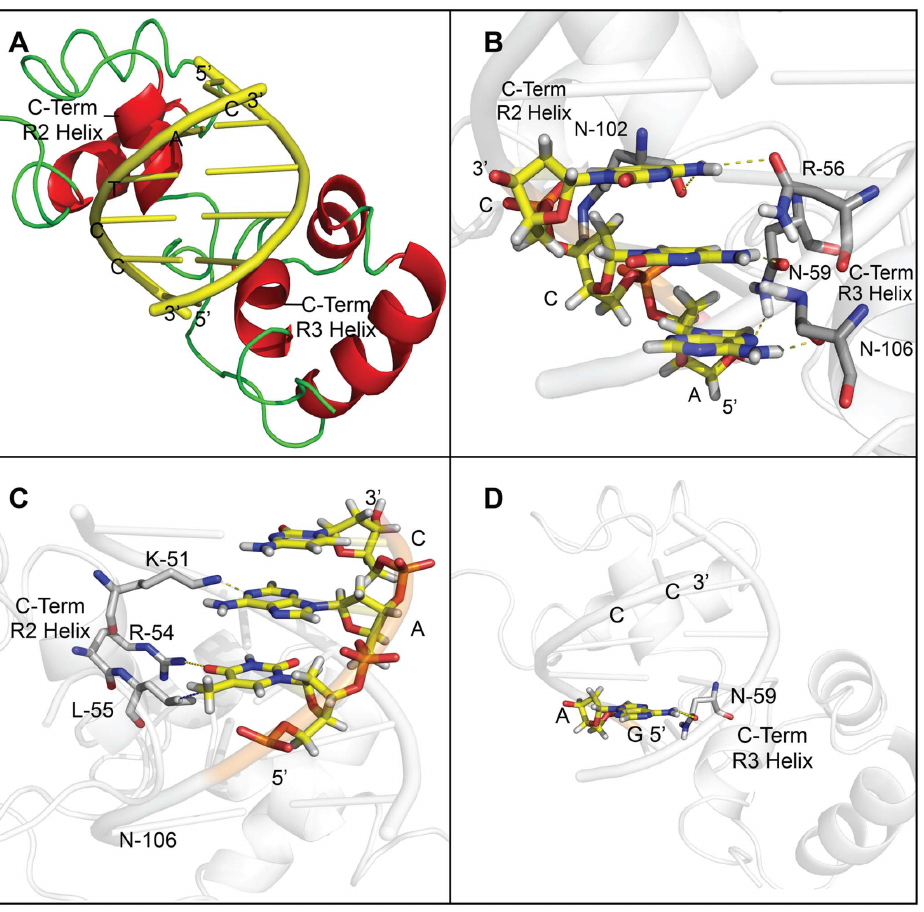
Figure 3. Molecular modelling of AtMYB61 with target sequences confirm binding preferences determined by nitrocellulose filter- binding assays and EMSAs. (A) Pymol models of ACCTAC motif docked into the binding site of AtMYB61. Molecular modelling was completed by using the online program PHYRE (Protein Homology/analogY Recognition Engine) to predict a crystal structure of AtMYB61 using homology to the c- MYB DNA binding domain. The PBD (protein data bank) file recovered from the PHYRE analysis was used to superimpose the predicted AtMYB61 crystal structure with the c-MYB crystal structure using DaliLite. Using Pymol the 3D sequence model – ACCTAC – was docked into the predicted binding sites of AtMYB61. The AC1 element model is displayed in yellow, the loop secondary structure of AtMYB61 inferred model is displayed in green, and the helix secondary structure of AtMYB61 inferred model is displayed in red. (B) Model of AtMYB61 binding site with the first three ACC nucleotides in the ACCTAC sequence determines that these nucleotides are essential for binding. The AC1 (ACCTAC) nucleotide model was docked into the predicted binding site of AtMYB61. The specific hydrogen bonding between the amino acids of AtMYB61 binding site to the ACC nucleotides of AC1 were predicted by Pymol and listed as follows: asparagine-59 (R3 helix) hydrogen to adenine-1 nitrogen; asparagine-106 (R3 helix) oxygen to adenine-1 hydrogen; asparagine-59 (R3 helix) oxygen to cytosine-2 hydrogen; asparagine-102 (R3 helix) oxygen to cytosine-3 hydrogen; and arginine- 56 (R2 helix) oxygen to cytosine-3 hydrogen. This confirms binding data determined by the nitrocellulose filter-binding assay and EMSAs, iterating that the ACC motif is the core recognition motif of AtMYB61. (C) Model of AtMYB61 binding site with the TAC nucleotides in the ACCTAC sequence determine that these nucleotides are less essential for binding. The AC1 (ACCTAC) nucleotide models were docked into the predicted binding sites of AtMYB61. The molecular interactions between the amino acids of AtMYB61 binding site and the TAC nucleotides of AC1 were analyzed by Pymol and are listed as follows: leucine-55 (R2 helix) methyl group was predicted to form a non-polar bond with thymidine-4 methyl group; Arginine-54 (R2 helix) hydrogen was predicted to form a hydrogen bound with thymidine-4 oxygen; lysine-51 (R2 helix) hydrogen was predicted to form a hydrogen bound with adenine-5 nitrogen; and cytosine-6 remained unbound in the model. (D) Model of AtMYB61 binding site with non-binding site (GAGACC) predicts that this motif is not recognised by AtMYB61. The non binding site model was docked into AtMYB61 binding site via Pymol and hydrogen bonding was analyzed. Only one hydrogen bond was predicted between AtMYB61 asparagine-59 (R3 helix) oxygen and the non-binding site adenine-2 hydrogen. Yellow dashed lines indicate hydrogen bonding established by Pymol program, and blue dashed lines indicate non-polar interactions. doi:10.1371/journal.pone.0065132.g003 binding. Previously, the structure of the N-terminal DNA-binding (ACCTAC) and NBS (GAGACC) nucleotide models were then domain of animal c-MYB bound to its DNA consensus motif docked into the predicted binding sites of the At MYB61 model (AACNG) was solved by heteronuclear multidimensional NMR (Figure 3). [31]. Animal c-MYB DNA-binding region contains a conserved Based on the model of At MYB61, the molecular interactions R2R3-MYB domain that exhibits high similarity to plant R2R3- shared between the binding sites of At MYB61 to its targets MYB DNA binding domains. This NMR structure was used as a supported in vitro binding data (Figure 3BCD). For example, there template to model the structure of At MYB61. The AC-I were more hydrogen bonds shared between At MYB61 DNA-